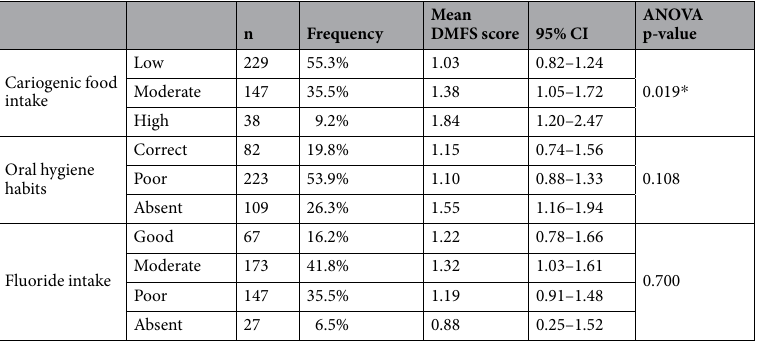
Table 2. Frequency of variables and mean DMFS score by variable. * Significant difference (p < 0.05).